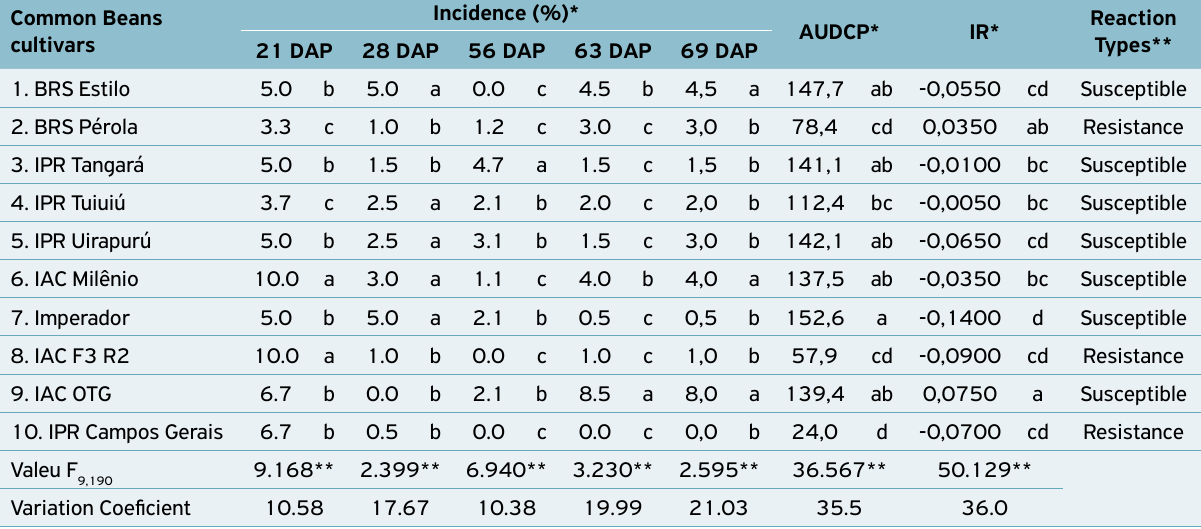
Table 1. Transformed averages (X + 10) of incidence of wilted and rotting base (%) on different DAP, AUDCP, GR, % day -1 ) and reaction types in different bean cultivars grown in the 2015-2016 harvest. Common Beans